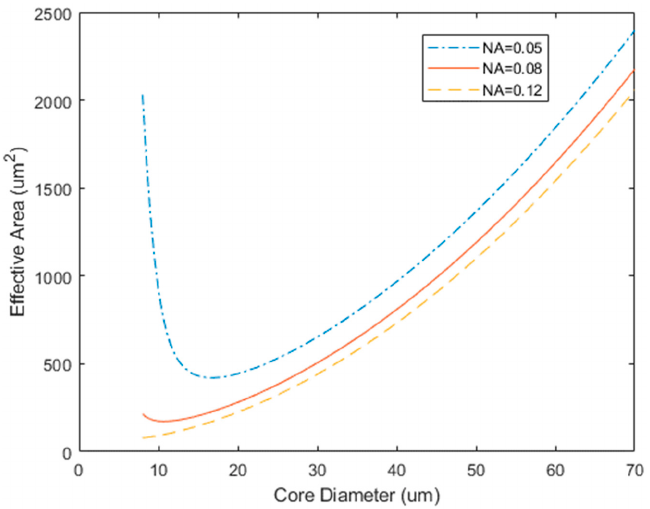
Figure 7. The relationship between the core diameter and mode effective area.